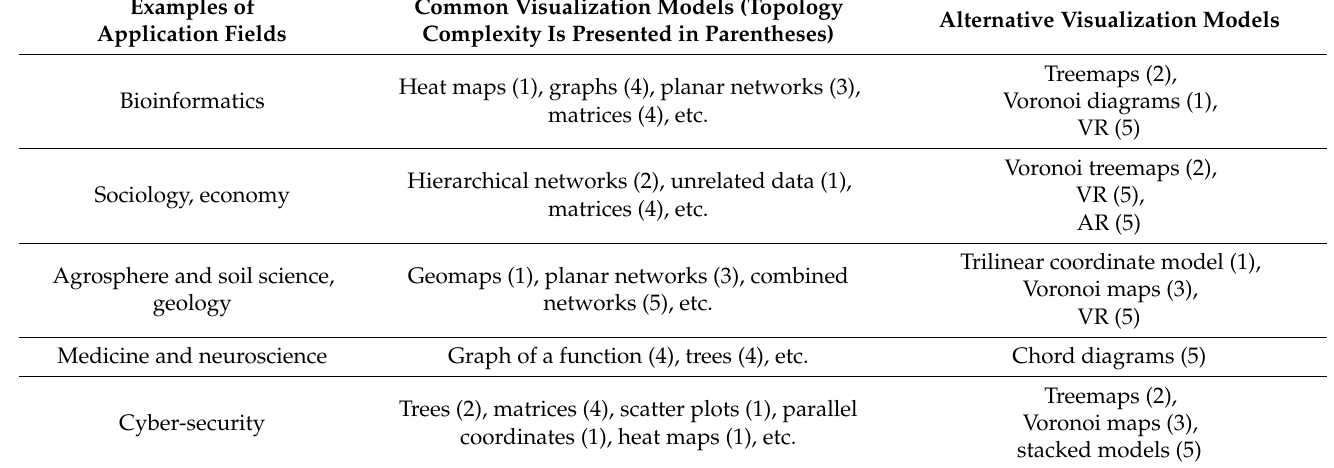
Table 3. Usage of visualization